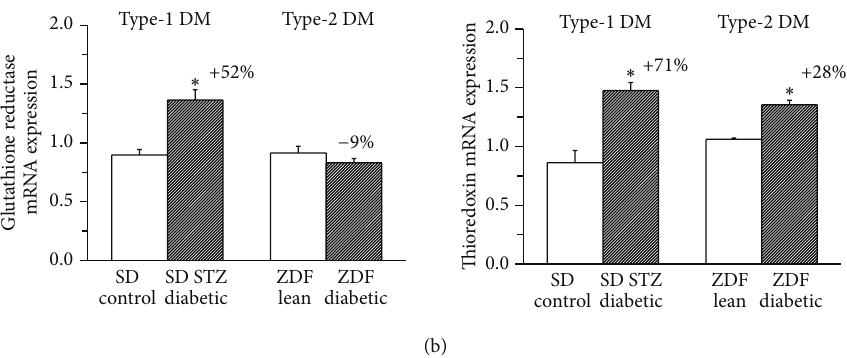
Figure 4: Characteristic changes in myocardial expression of genes involved in the development of diabetic cardiomyopathy (a) and genes of endogenous antioxidants (b) in type-1 and type-2 diabetes mellitus (DM) models. Relative mRNA expression for (a) hypertrophy markers 𝛼 myosin heavy chain (MHC), 𝛽 -MHC, early genes of the hypertrophic transcriptional program c-fos and c-jun; extracellular matrix components collagens 1 and 3, vascular endothelial marker endothelial nitric oxide synthase (eNOS) and endothelin-1 (ET-1); atrial natriuretic factor (ANF) and proapoptotic caspase-12, as well as for (b) endogenous antioxidants superoxide dismutase 1 (SOD1) and 2 (SOD2), catalase, glutathione reductase and thioredoxin in the groups of SD control, streptozotocin- (STZ-) induced diabetic SD, Zucker Diabetic Fatty (ZDF) lean and ZDF diabetic rats. Bar graphs represent mean ± SEM. Percent changes between diabetic and corresponding nondiabetic control groups are indicated in both DM models. ∗ : 𝑃 < 0.05 versus the corresponding nondiabetic group.